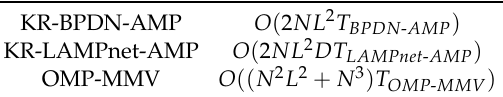
Table 2. Computational